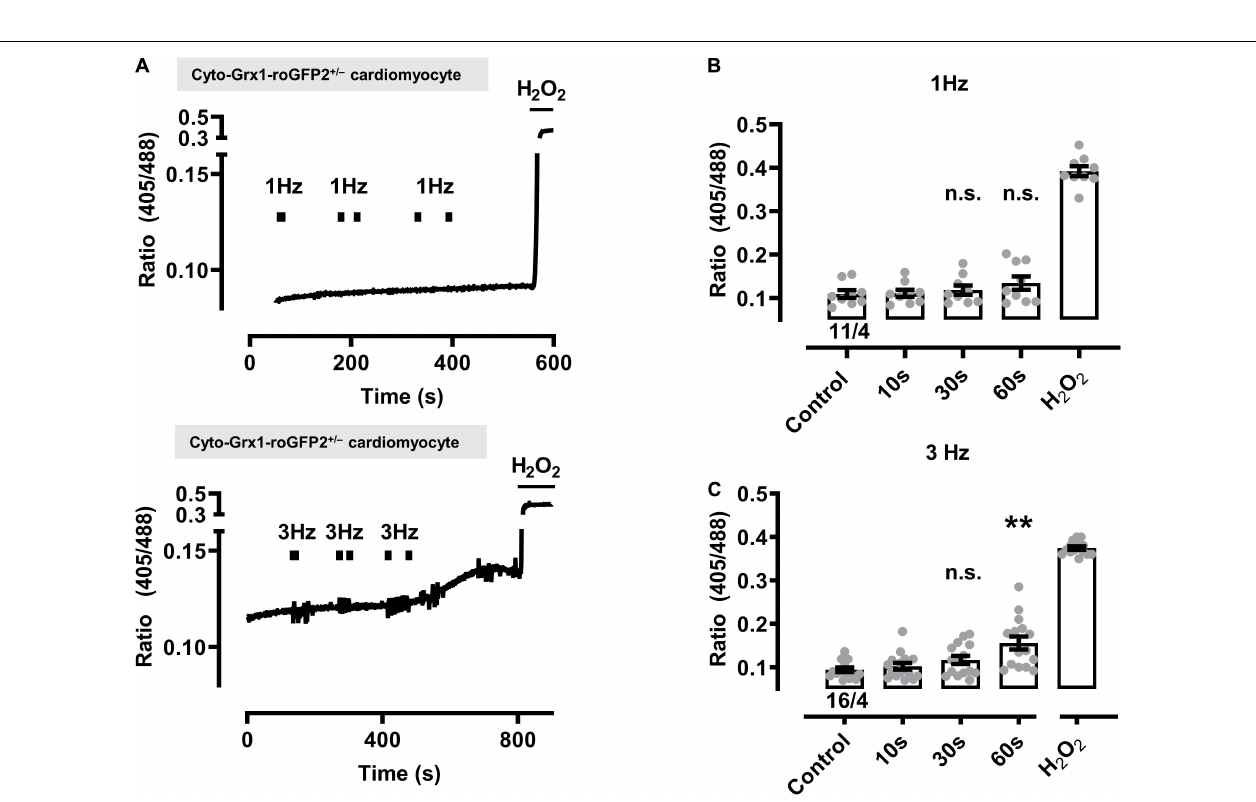
FIGURE 3 | Effect of contractile activity induced by electrical field stimulation (EFS) on the redox sensor signal in cardiomyocytes from cytosolic Grx1-roGFP2 + / − mice. (A) Representative time course of the redox signal (ratio I405/I488) with contractile activity by EFS at 1 Hz (above) and 3 Hz (below). Marks indicate the start and stop of the stimulation interval which lasted 10, 30, and 60 s, respectively. H 2 O 2 (200 µ M) was added at the end of each experiment to obtain the maximal oxidized value. Up and down reflections of the signal represent low-frequency ( < 0.1 Hz) contractions of the myocyte. (B) Mean values ± SEM of ratio values obtained in cardiomyocytes under control conditions and after EFS at 1 Hz with a 10, 30, and 60 s duration. The signal values of each cardiomyocyte were obtained under control conditions and after the respective pacing. We used 11 cells from four mice as indicated. Statistical analysis was performed by paired one-way ANOVA with Dunnett’s post-test. n.s., non-significant. (C) Mean values ± SEM of ratio values obtained in cardiomyocytes under control conditions and after EFS at 3 Hz with a 10, 30, and 60 s duration. We used 16 cells from four mice as indicated. Statistical analysis was performed by paired one-way ANOVA with Dunnett’s post-test. ** P = 0.008; n.s.,